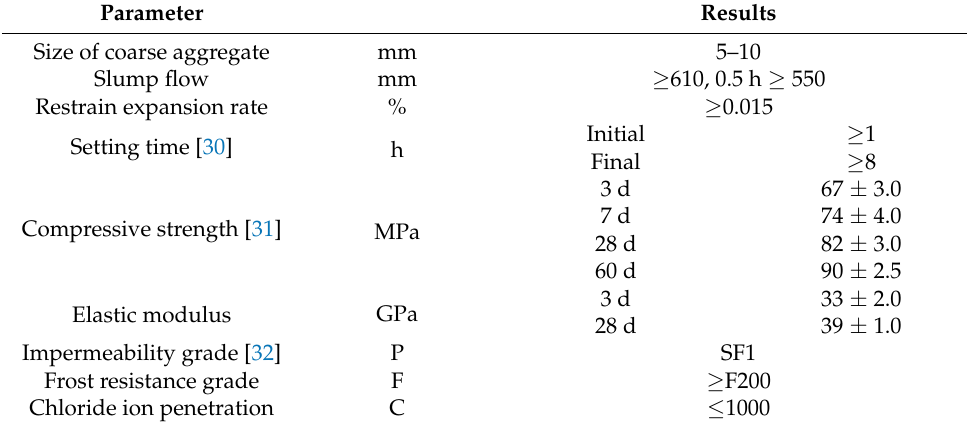
Table 4. Mechanical properties of the ESS-HPC.